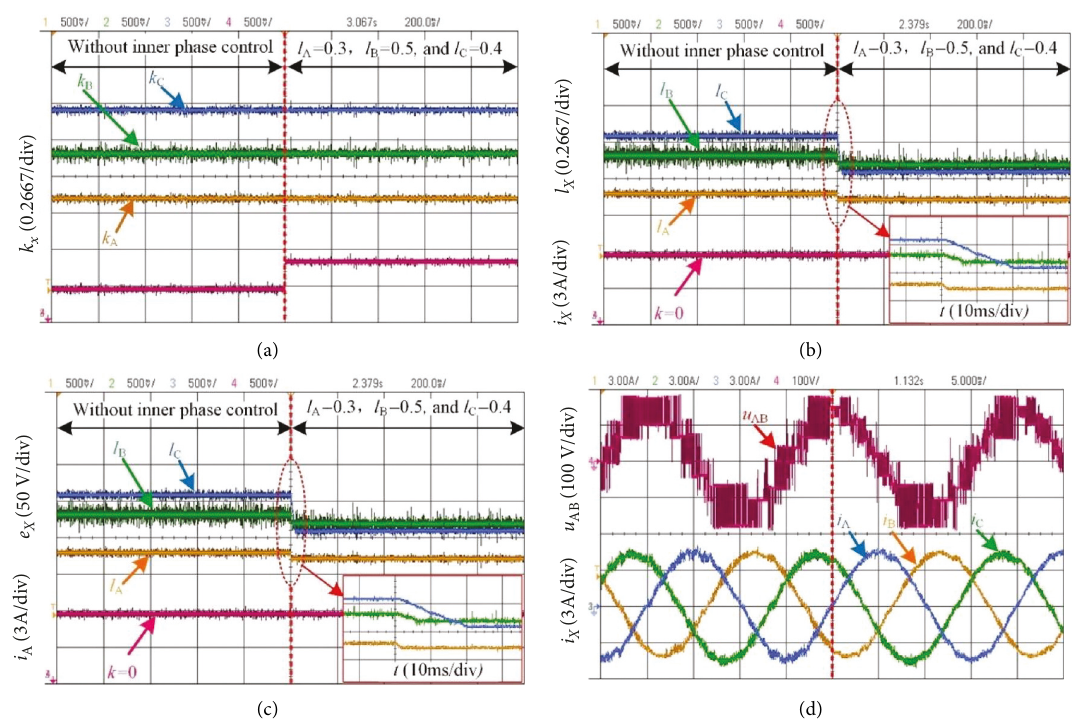
Figure 7: The experimental results in with r A (cid:31) 2/3, r B (cid:31) 1, and r C (cid:31) 4/3: (a) waveforms of power generation ratios k X , (b) waveforms of submodule power generation ratios l Xn , (c) phase current i A and the grid voltage e X , and (d) waveforms of line voltage u XX and currents i X